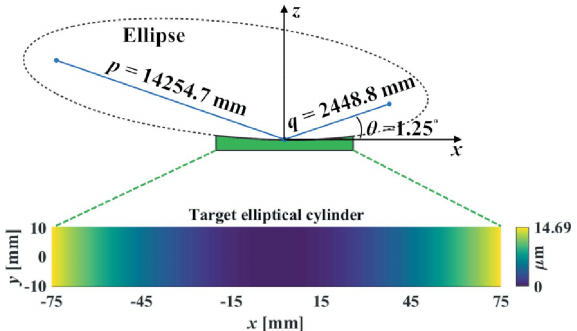
Figure 10 Initial spherical mirror with ROC = 199 m.